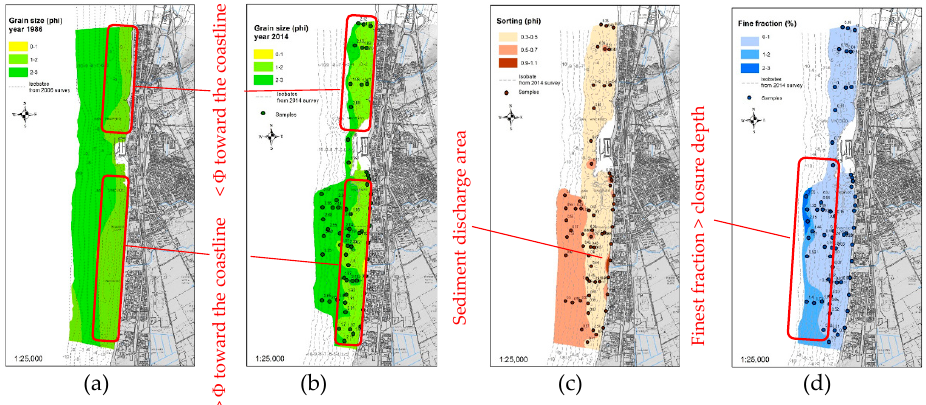
Figure 14. Sedimentological maps; ( a ) mean (Mz) grain-size map ( Φ ) extracted from 1986 report by the University of Florence; ( b ) mean (Mz) grain-size map obtained by analysis of sample gathered in 2014; ( c ) sorting map ( Φ ) obtained by analysis of sample gathered in 2014; ( d ) fine fraction map (%) obtained by analysis of sample gathered in 2014.